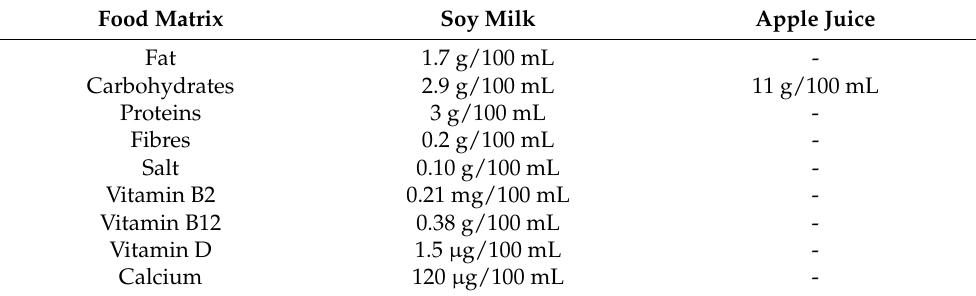
Table 1. Composition of soy milk and apple juice.